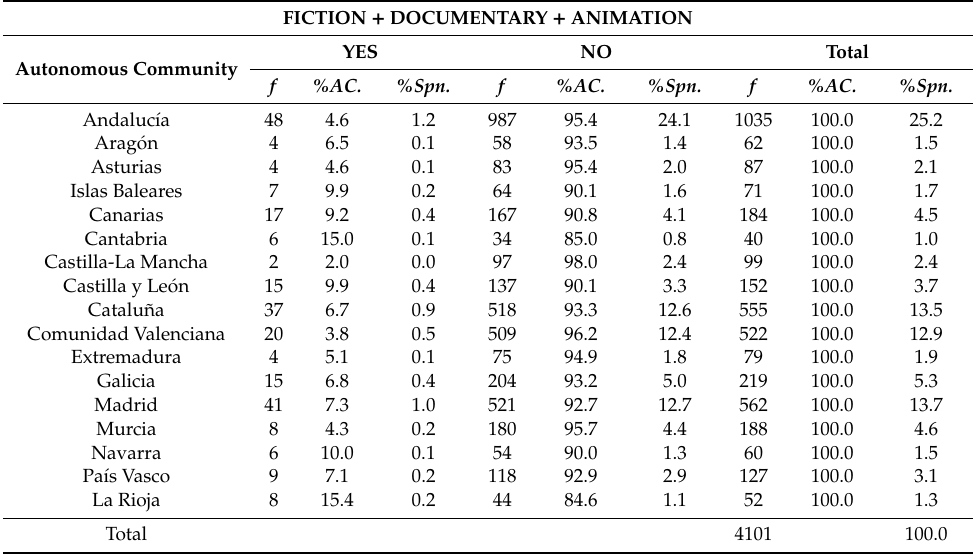
Table 10. Percentages and frequencies of fiction, documentary and animation films seen by teacher (cid:48) s degree students, according to the Autonomous